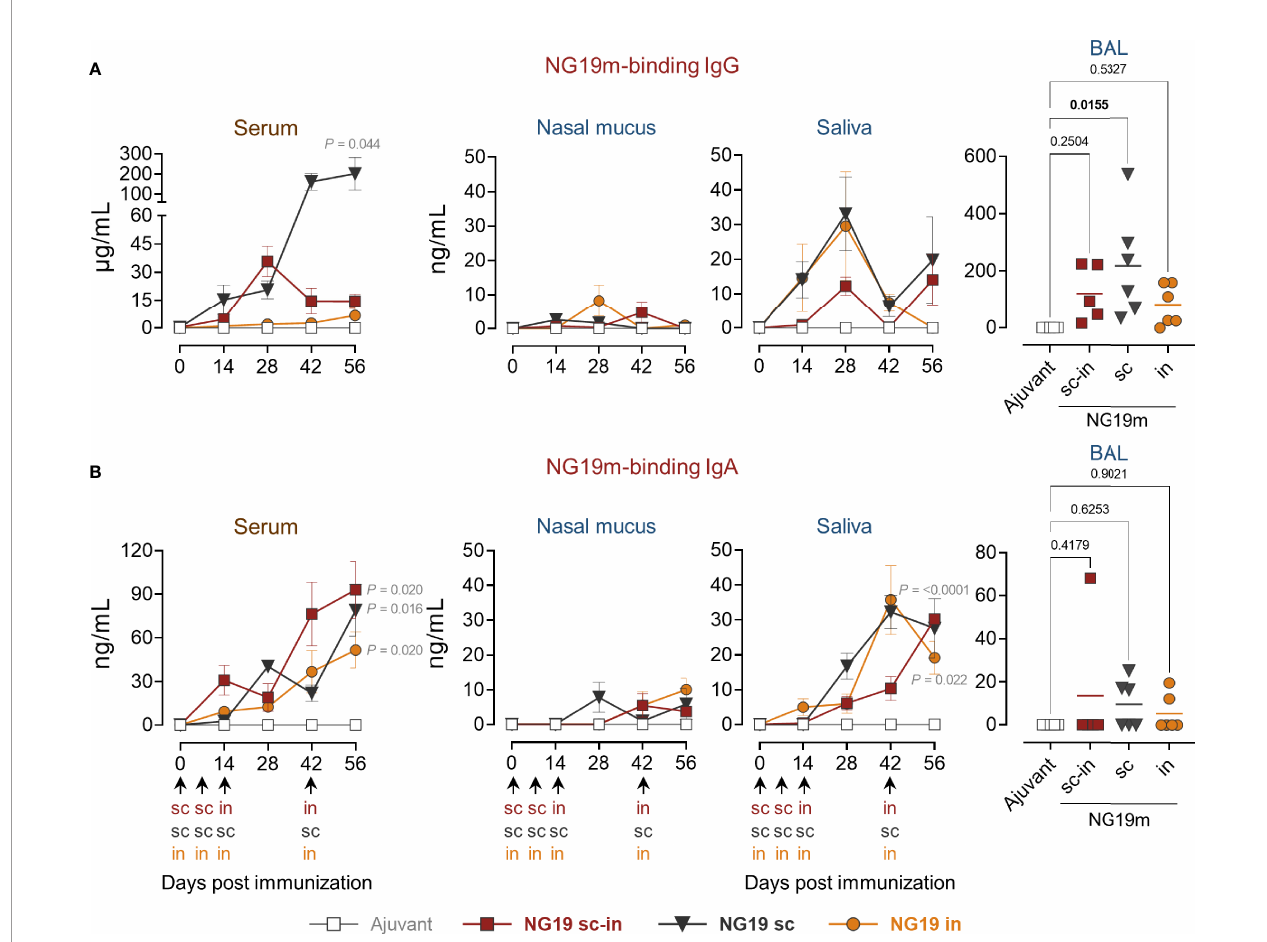
FIGURE 5 | NG19m-immunized pigs generated antigen-speci fi c serum and mucosal antibodies. Animals were immunized in the fi rst two doses with 100 µg of NG19m protein mixed with alum 1:1 (v/v) and 200 µg of NG19m without adjuvant in the third and fourth immunizations. Kinetics of serum and mucosal NG19m- binding IgG (A) and IgA (B) , assayed by quantitative ELISA using NG19m protein. Differences in the kinetics of antibodies were analyzed utilizing two-way ANOVA with the Geisser-Greenhouse correction, followed by Dunnett´s (comparison with the control group) and Tukey´s (comparison among the groups) multiple comparisons. Ordinary one-way ANOVA followed by Tukey´s multiple comparisons was applied to evaluate differences in BAL samples. In BAL graphs the scales are different. Error bars represent SEM. In the kinetics of antibody production graphs, P values ≤ 0.05 are indicated for day 56